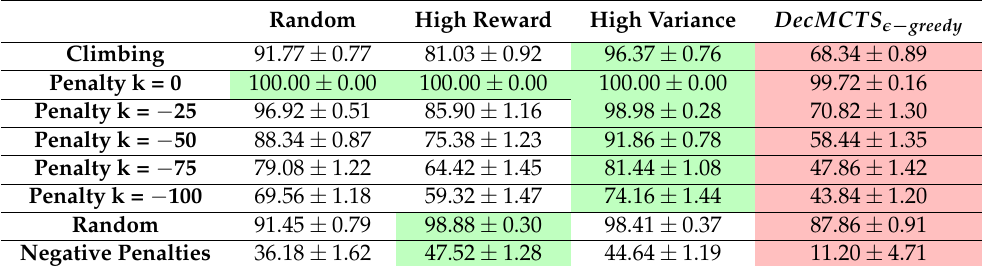
Table 2. The performance of combined decoupled-MCTS with different action combination strategies. Random High Reward High